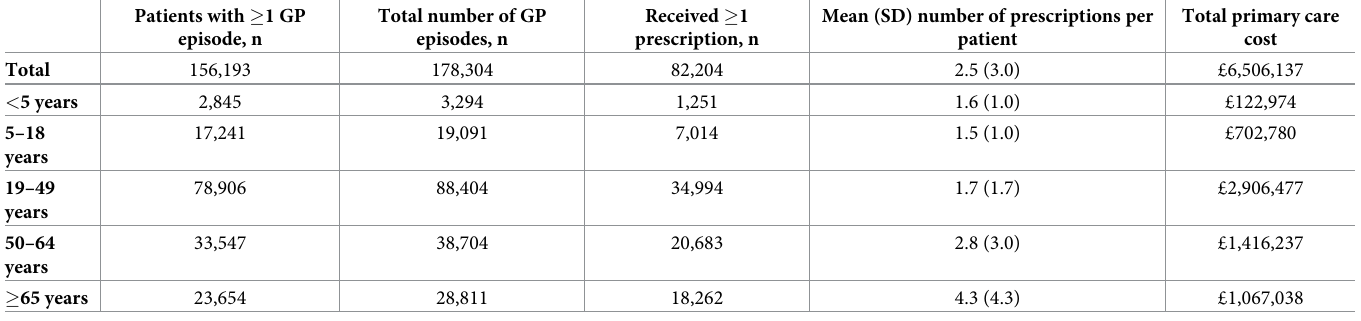
Table 1. Primary care resource use and direct medical costs of acute respiratory illness by age and complication status in the CPRD population during influenza seasons from 2001 to 2009. Patients with � 1 GP episode, n